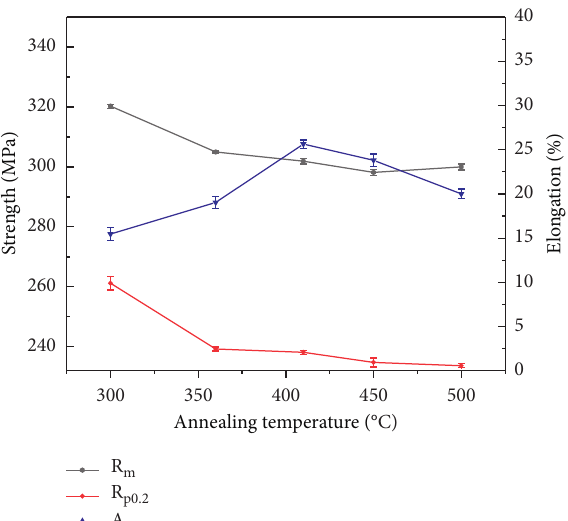
Figure 6: Relationship between mechanical properties of hot-rolled, four-layered aluminum alloy clad sheets and temperature (holding for 2h; R m , R p0.2 , and A represent tensile strength, yield strength, and percentage elongation,